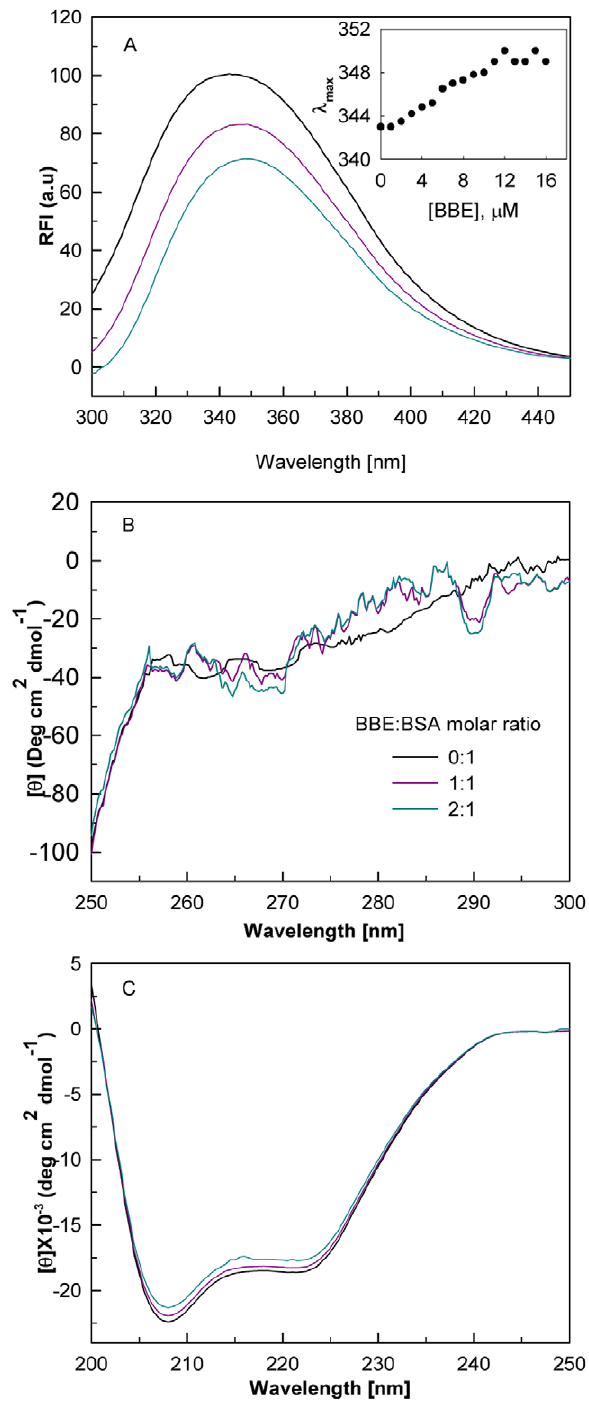
Figure 6. The BBE-induced conformational alterations in BSA. The intrinsic fluorescence (A), near-UV CD (B) and far-UV CD (C) spectra of BSA in the presence of BBE/BSA molar ratios of 0:1, 1:1 and 2:1, respectively. The inset of figure A shows the changes in emission maximum ( l max ) with increasing BBE concentrations.